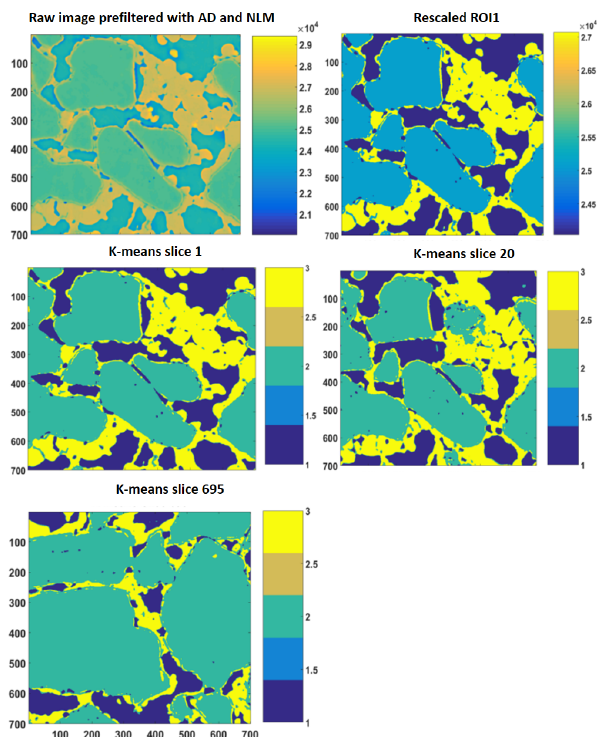
Figure 5. 2-D slices of REV 1 are represented above. The raw im- age is first filtered with anisotropic diffusion filtered and later on with non-local means. Thereafter, the different phases were segre- gated using a segmentation and indexing approach, and the raw im- age(s) were rescaled such that there was no overlap or mixed phases within the raw image; an example is shown as the rescaled 2-D ROI plot. Thereafter, k -means segmentation is performed on the com- plete stack; 2-D images of slice 1, slice 20 and slice 695 are shown as